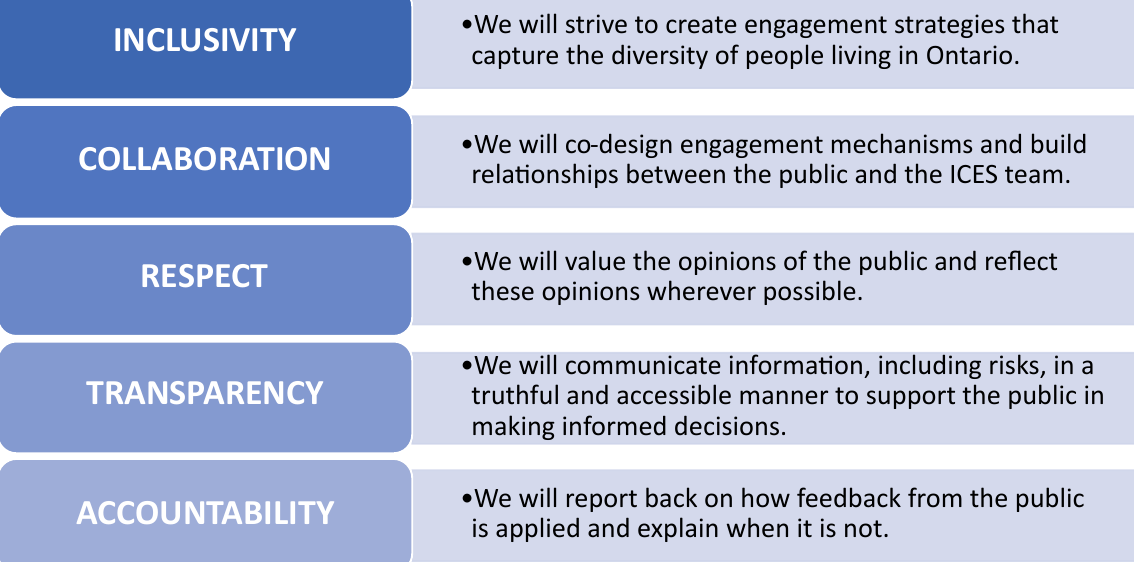
Figure 1: ICES’ principles for engagement